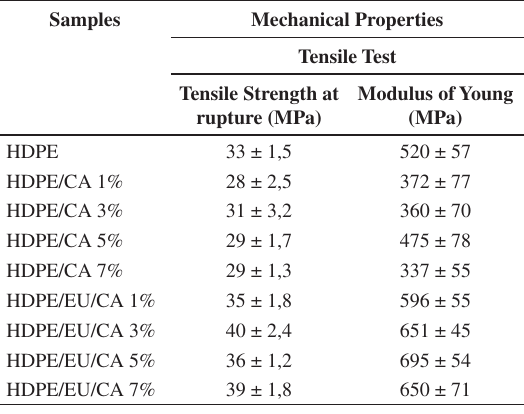
Table 3. Tensile strength at break of HDPE, compatibilized HDPE matrices and composites.